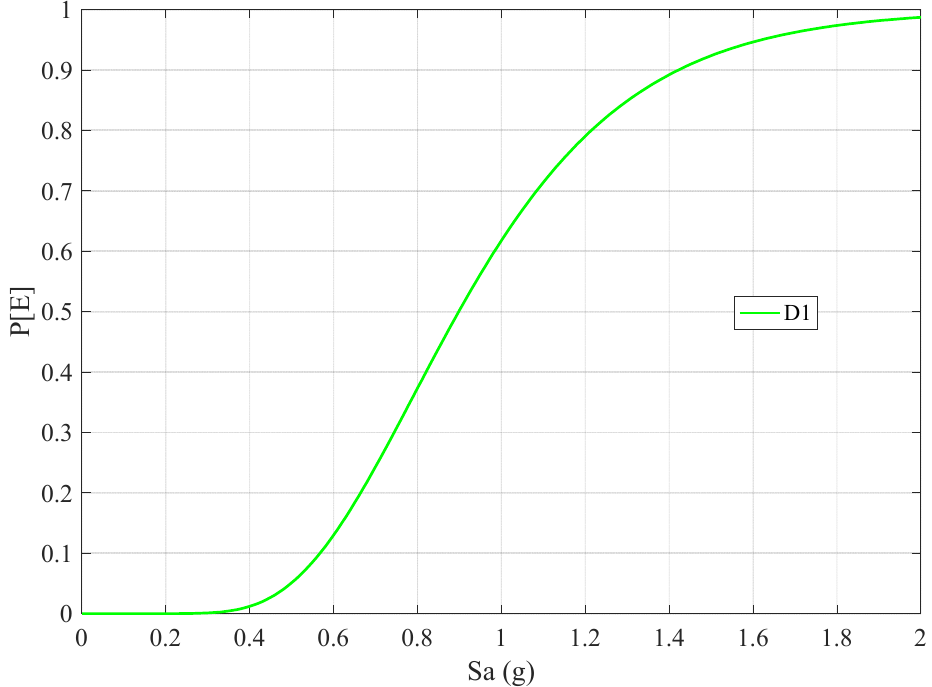
Figure 8. Foreshock fragility functions for low-rise SMRF buildings.